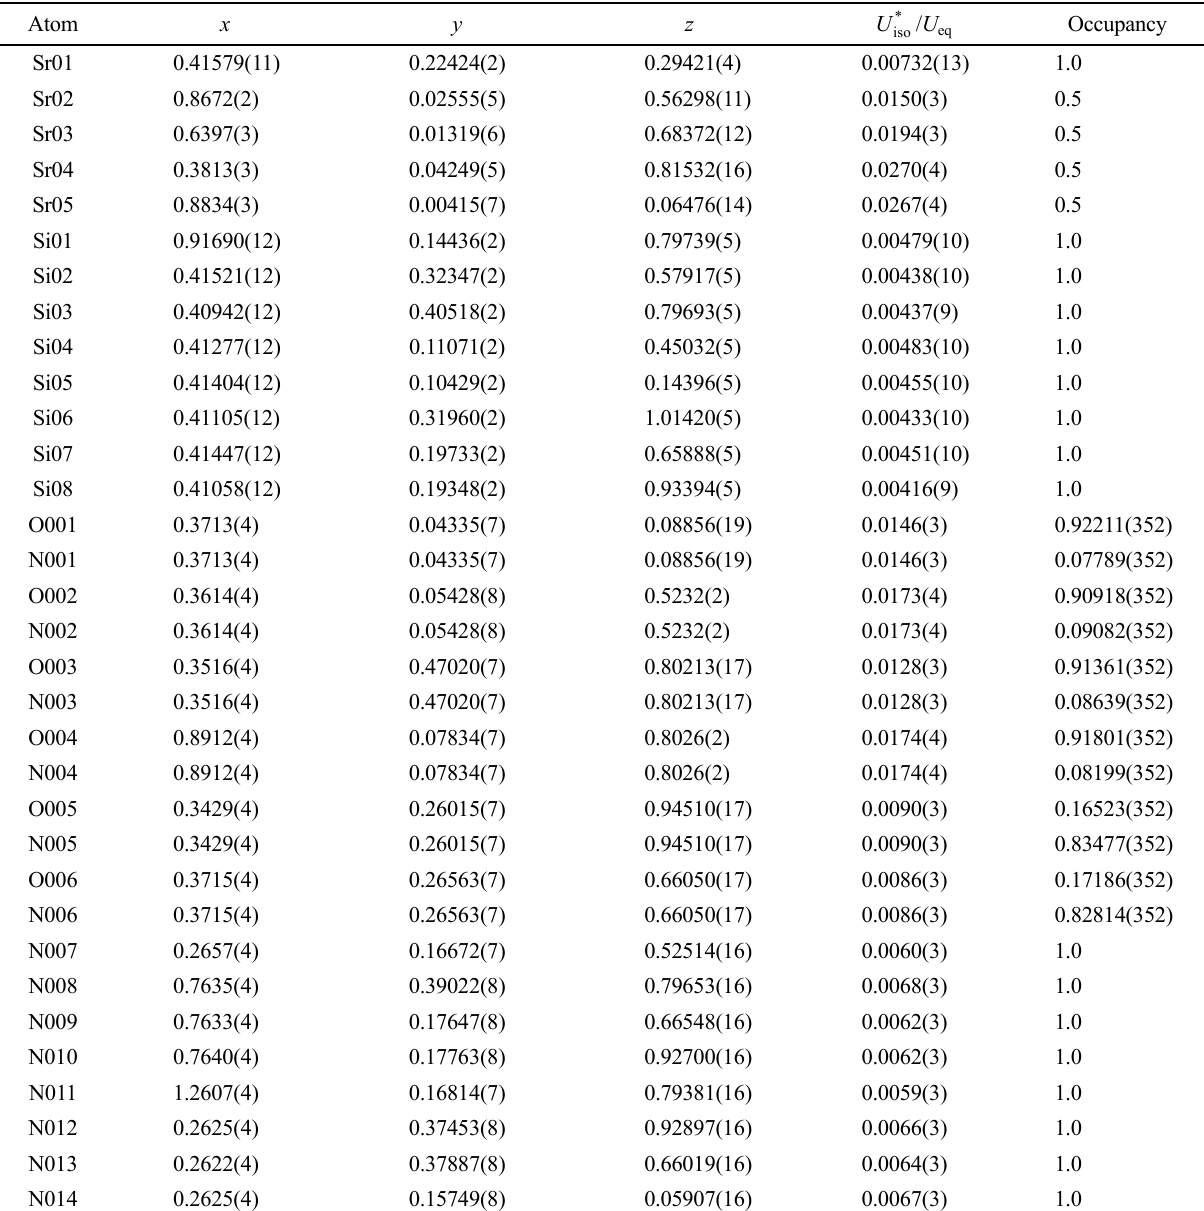
U ) or equivalent ( U eq ) isotropic displacement iso